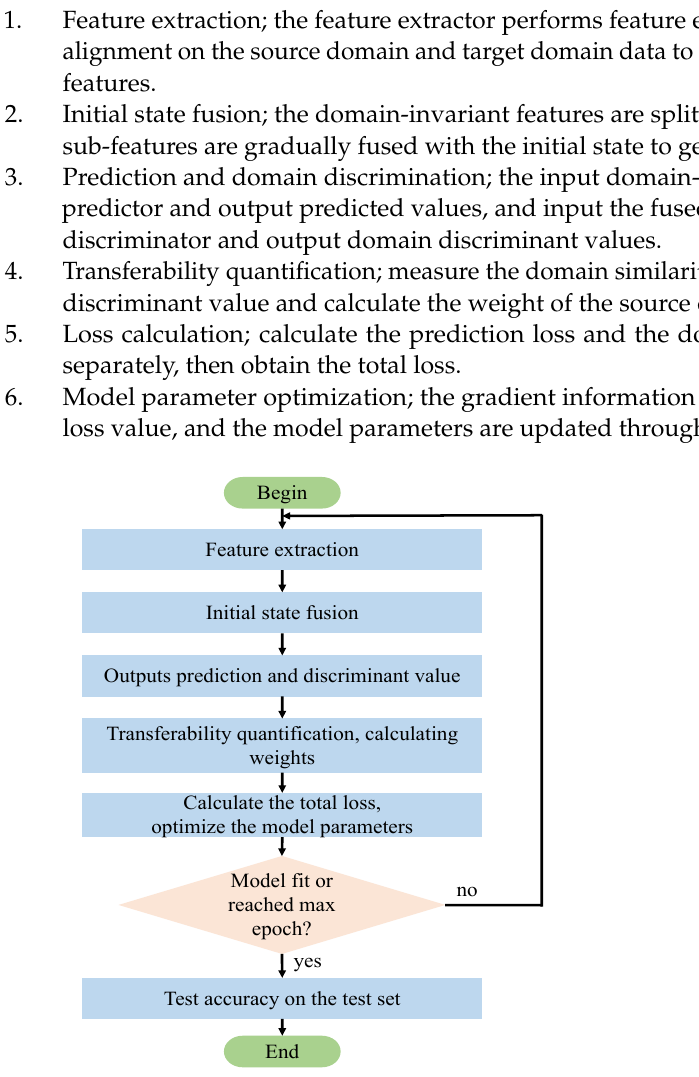
Figure 4. Algorithm flow